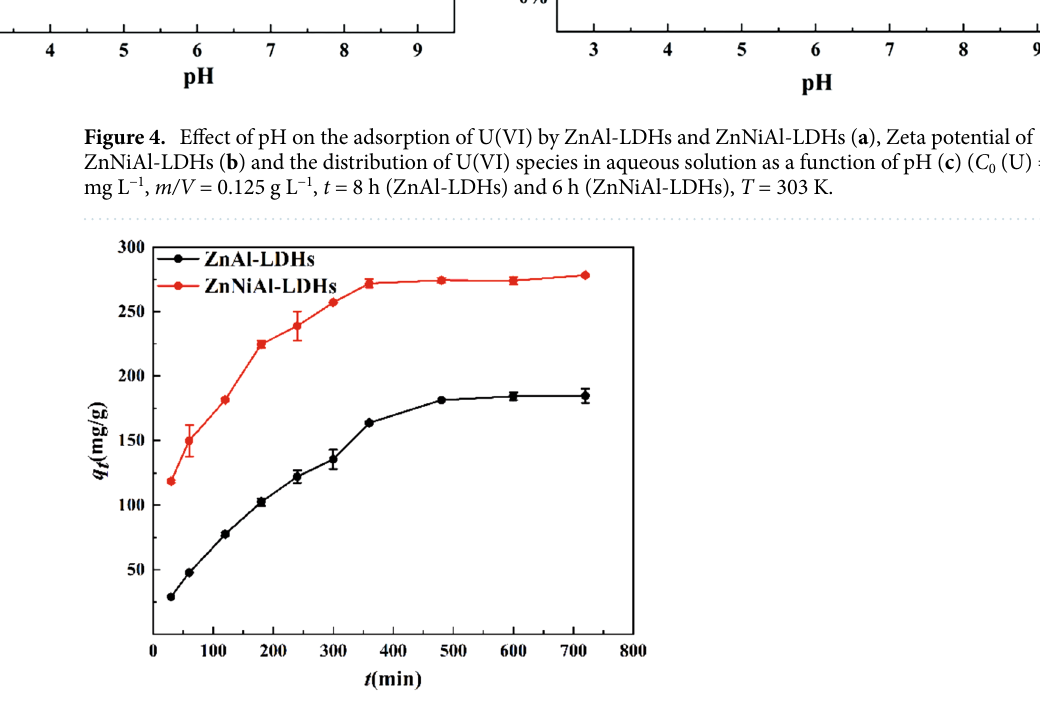
Figure 5. Adsorption kinetics of U(VI) on ZnAl-LDHs and ZnNiAl-LDHs ( C 0 (U) = 35 mg L −1 , m/V = 0.125 g L −1 , pH = 6.0, T = 303